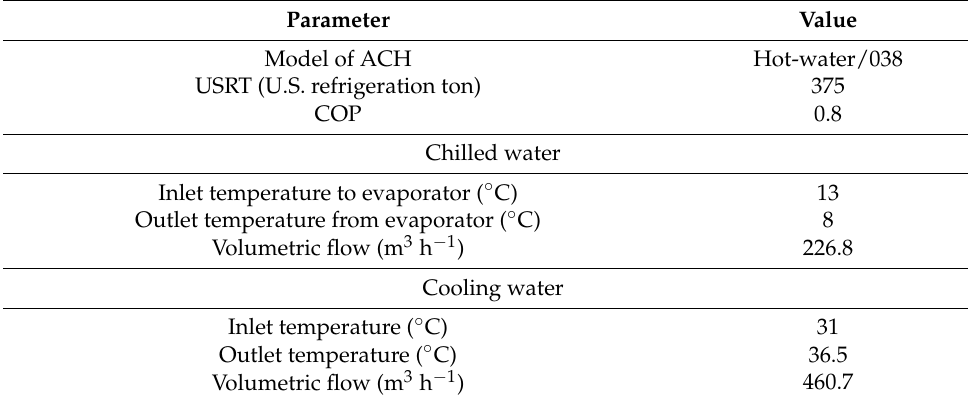
Table A8. Parameters of ACH exploiting external heat. Source: